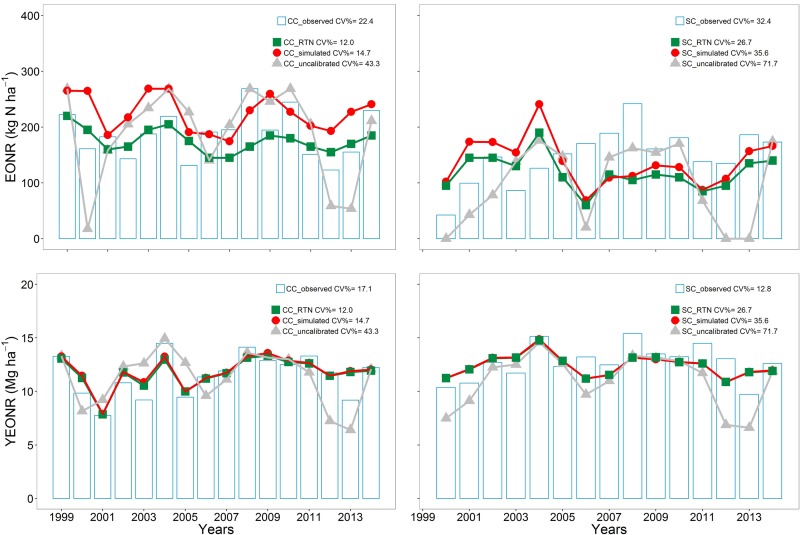
Economic optimum N rate (EONR) and corn yield at the EONR (YEONR) for every year in CC and SC. The EONR and YEONR estimates from observations using Eqs. 1-3 are shown as bars. Different color symbols show Agricultural Production Systems sIMulator (APSIM) model simulations: red points calibrated model, gray points uncalibrated model, and green points return to N approach (RTN) from the calibrated model.